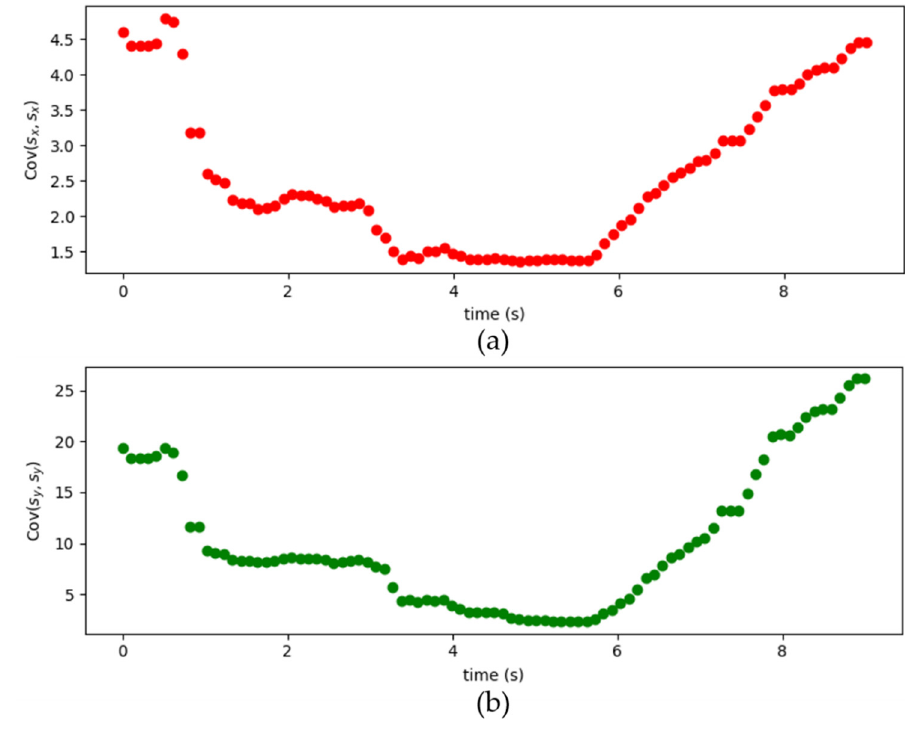
Figure 17. The ( a ) Cov ( s x , s x ) and ( b ) Cov ( s y , s y ) in the Q 2 matrix.